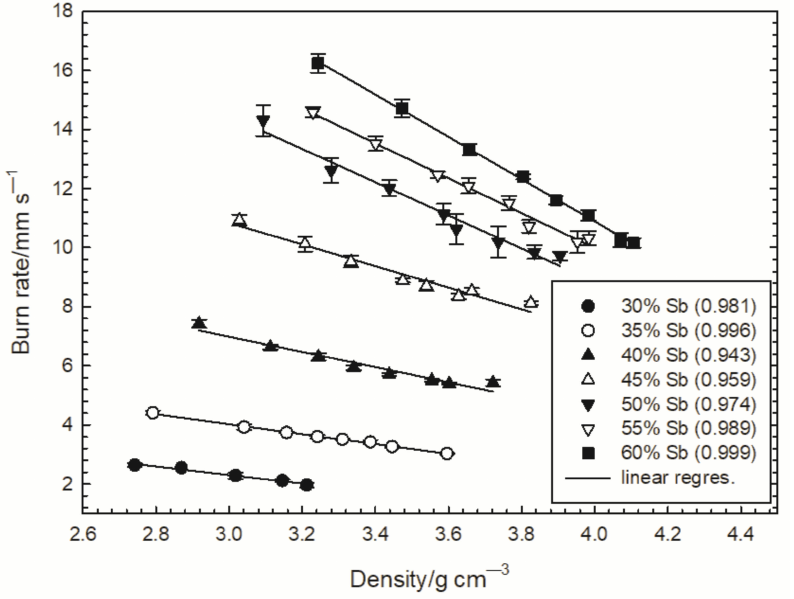
Figure 6. Dependence of the burning rate of tested compositions on the loading density (the correla- tion coefficient R2 is given in